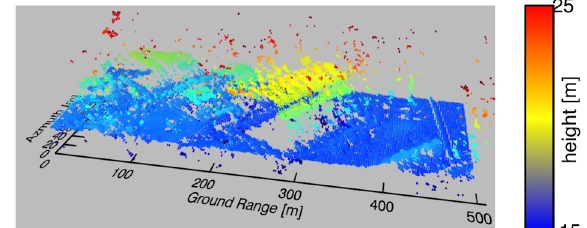
Figure 5: Reflectivity reconstruction using SP-MUSIC-1 (1 scat- terer assumed). Color corresponds to the height of the scatterers. Note the presence of lot of artifacts, specially points located in the “air”. Data are represented in a ground range geometry.